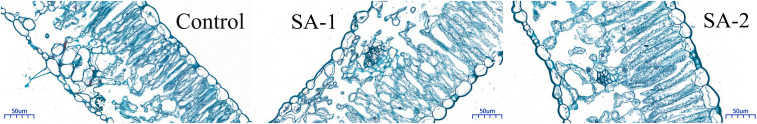
Tissue structure of fresh tobacco leaves treated with different salicylic acid concentration.